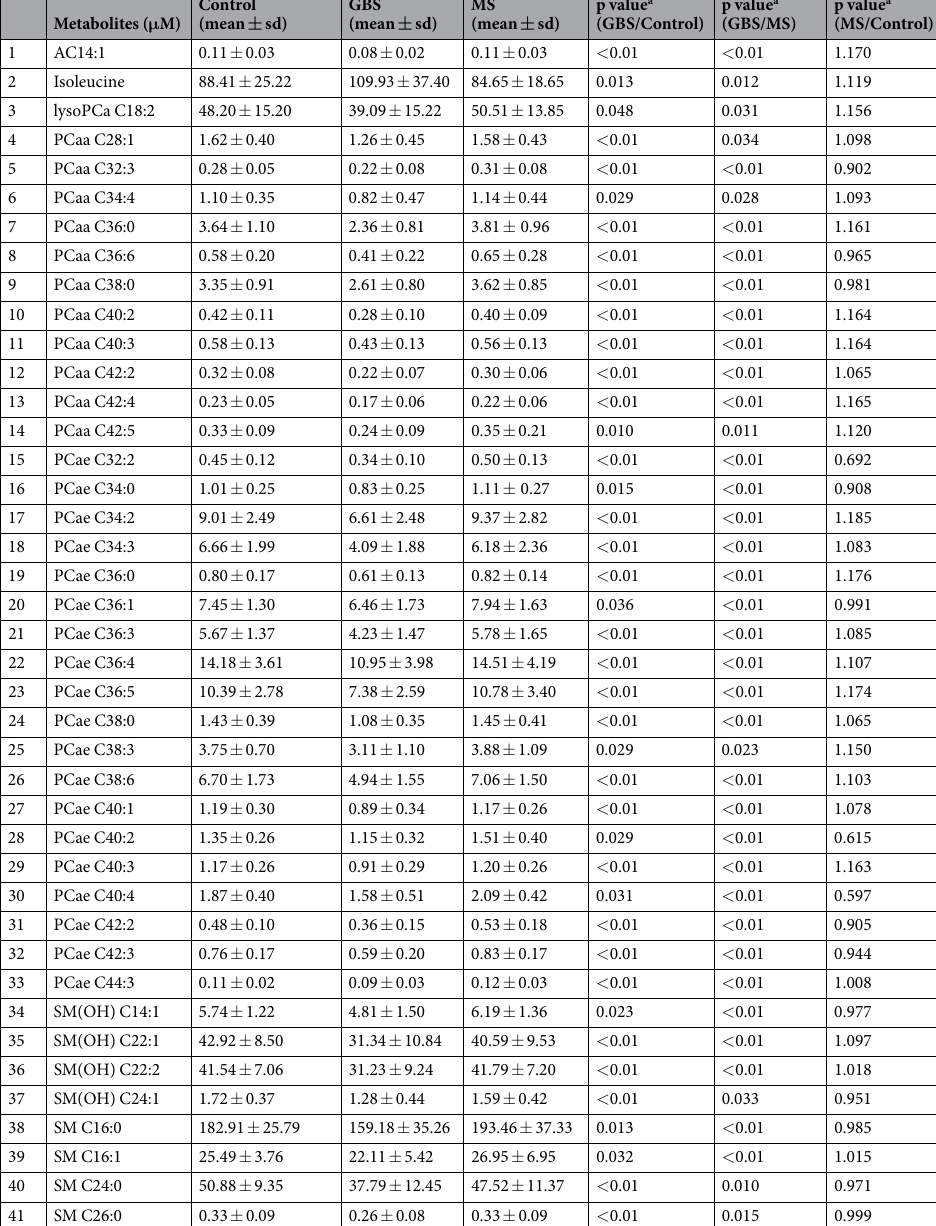
Table 2. Levels of significantly changed metabolites in GBS patients compared to healthy controls and MS patients revealed by targeted metabolomics analysis. a One-way ANOVA with Tukey’s post hoc test and with FDR correction. Abbreviations: GBS, Guillain-Barre syndrome; MS, multiple